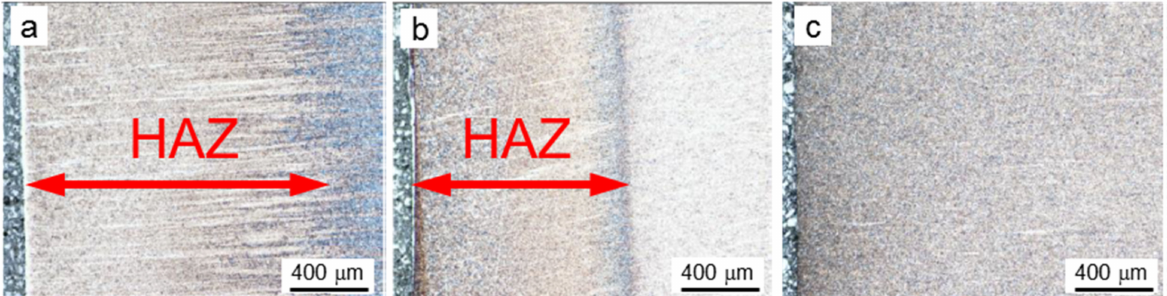
Figure 1. Optical microscopy images of heat affected zone in Steel H cut with ( a ) oxy-fuel, ( b ) plasma, and ( c ) water-jet.